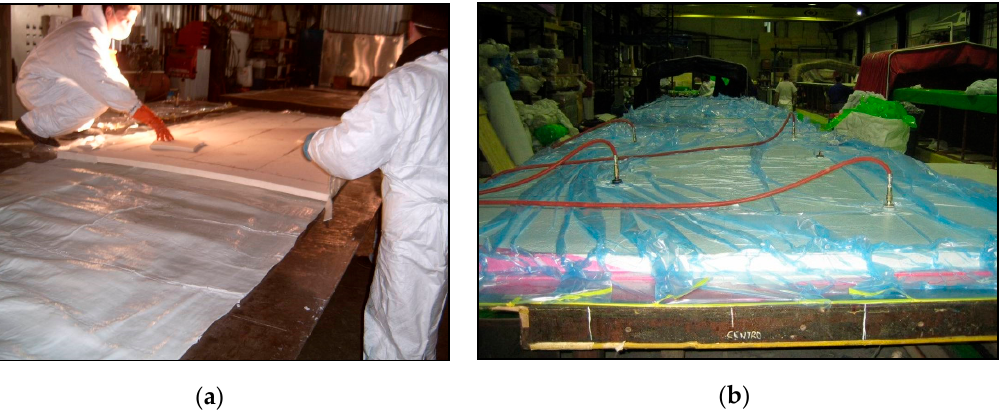
Figure 1. ( a ) Laying pre-pregs with polyurethane foam; ( b ) Using vacuum pump technology to consolidate panel layers (photo Mostostal Warszawa).